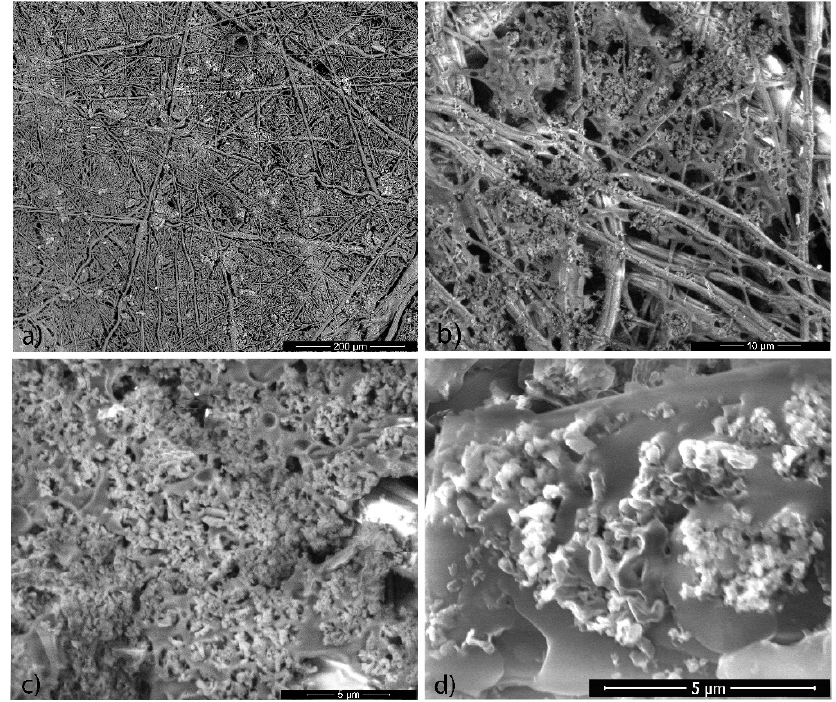
Figure 3. HRSEM images of the modified S4 fabric at di ff erent magnifications: ( a ) 400 × , ( b ) 6000 × , ( c ) 12,000 × and ( d ) 20,000 ×.